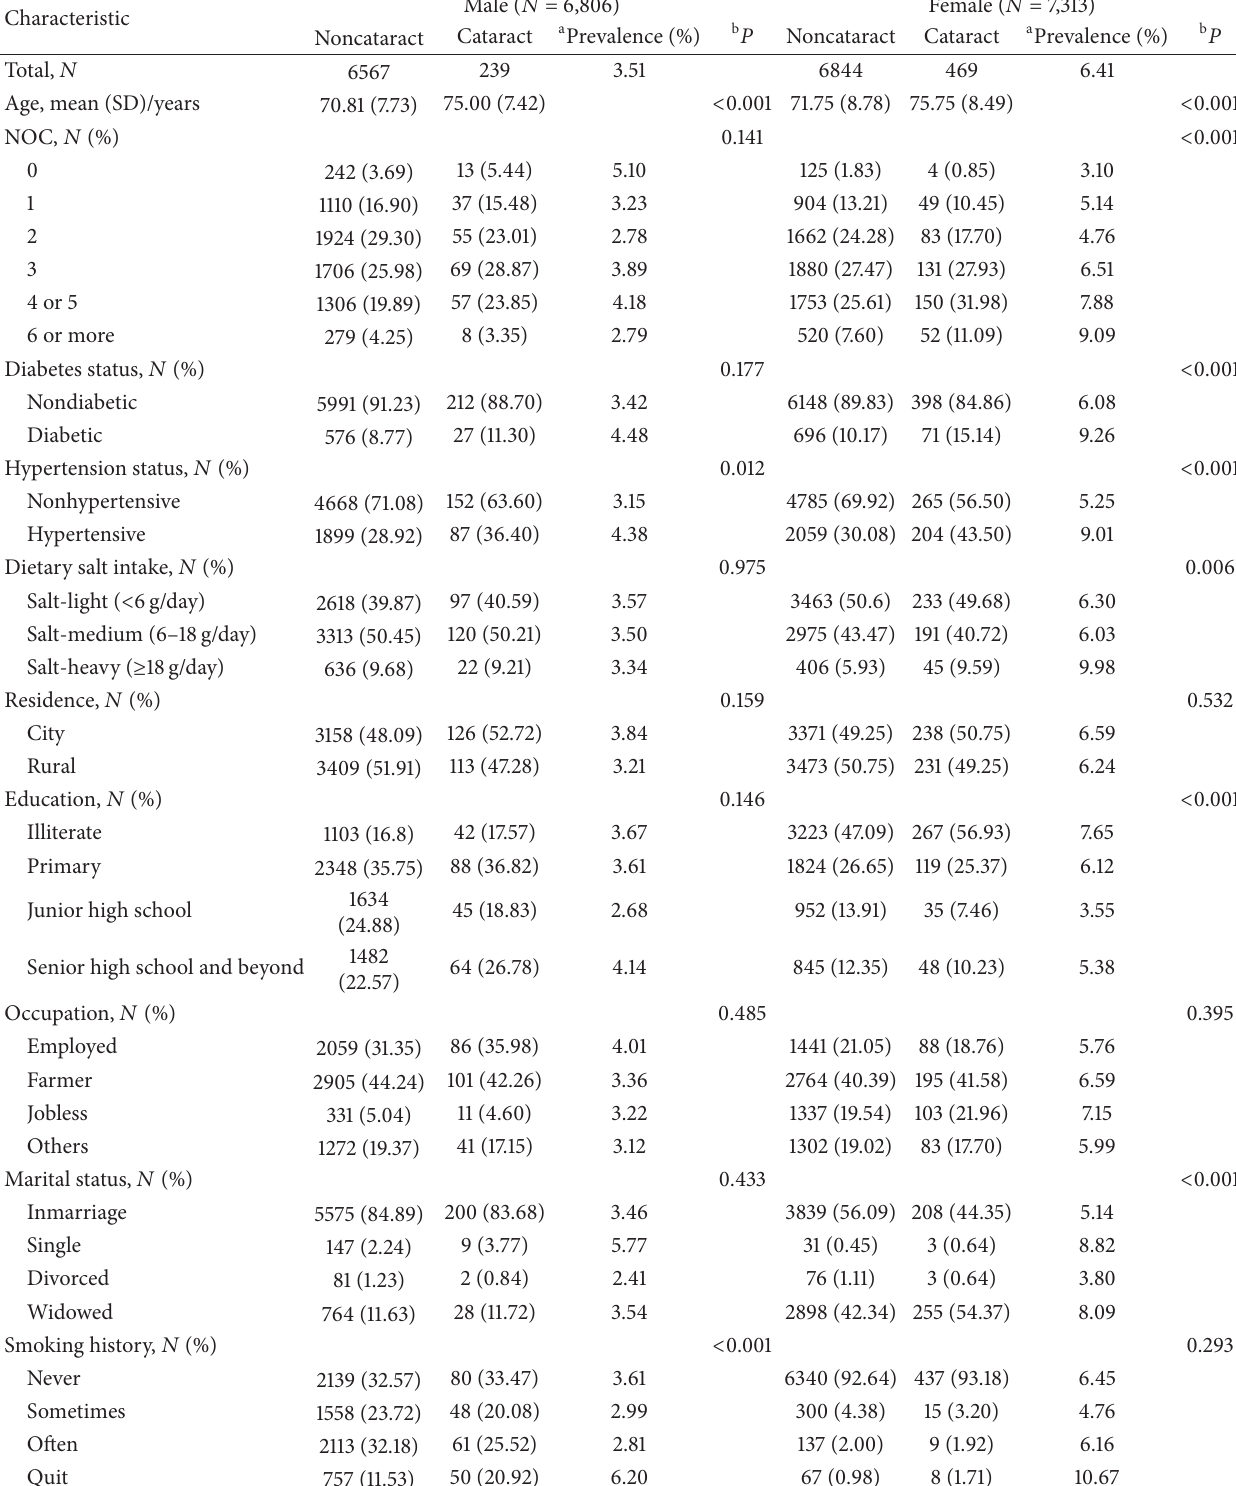
Table 1: Summary of gender stratified basic characteristics of 14,119